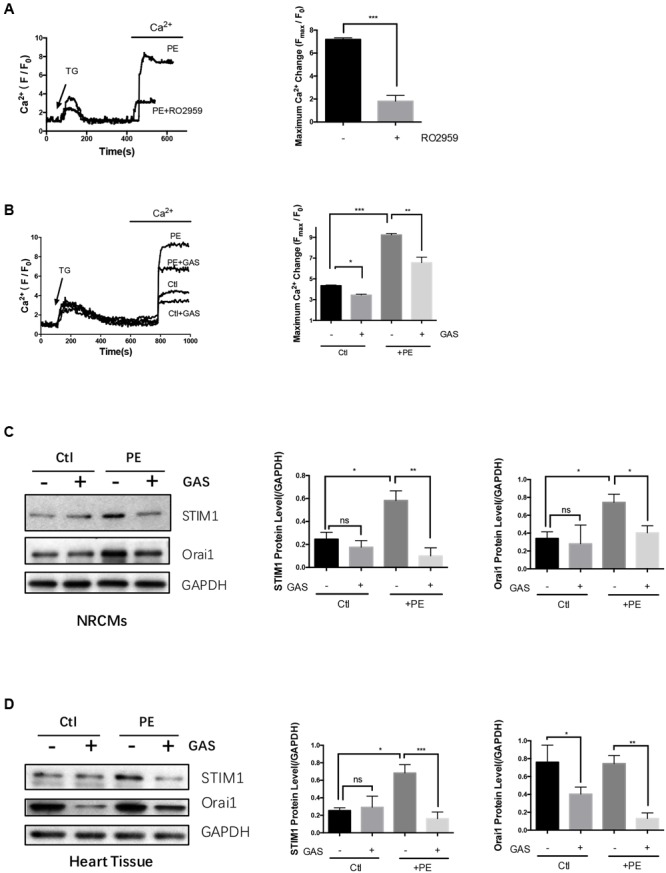
Chronic gastrodin treatment inhibited SOCE and reduced the expression of STIM1 and Orai1. NRCMs were treated with 50 μmol/L PE for 48 h to induce hypertrophy. (A) Acute effect of RO2959 on SOCE in phenylephrine-treated hypertrophic cardiomyocytes. The cells were treated with 4 μmol/L thapsigargin (TG) in a Ca2+-free bath, which induced the first Ca2+ rise, followed by adding back 1 mmol/L Ca2+ to the bath, which induced the second Ca2+ rise. The second Ca2+ rise is due to SOCE. RO2959 at 5 μmol/L was applied 5 min before TG. The representative traces (left) and data summary (right) of Ca2+ responses are shown. Only SOCE is plotted in the summary chart. (B) Effect of chronic gastrodin treatment on SOCE. GAS at 100 μmol/L was applied 12 h before PE. The control group (Ctl) did not undergo PE treatment. (C,D) Effect of gastrodin on the protein expression of STIM1 and Orai1 in NRCMs in vitro
(C) and heart tissue in vivo
(D). The representative images (left) and data summary of immunoblots (right) are shown. GAPDH was used as the house-keeping control gene. The data are expressed as the mean ± SEM [n = 5 repeats, >15 cells per repeat in (A,B); n = 5 in (C,D)]. ∗p < 0.05; ∗∗p < 0.01; ∗∗∗p < 0.001. ns, not significant.